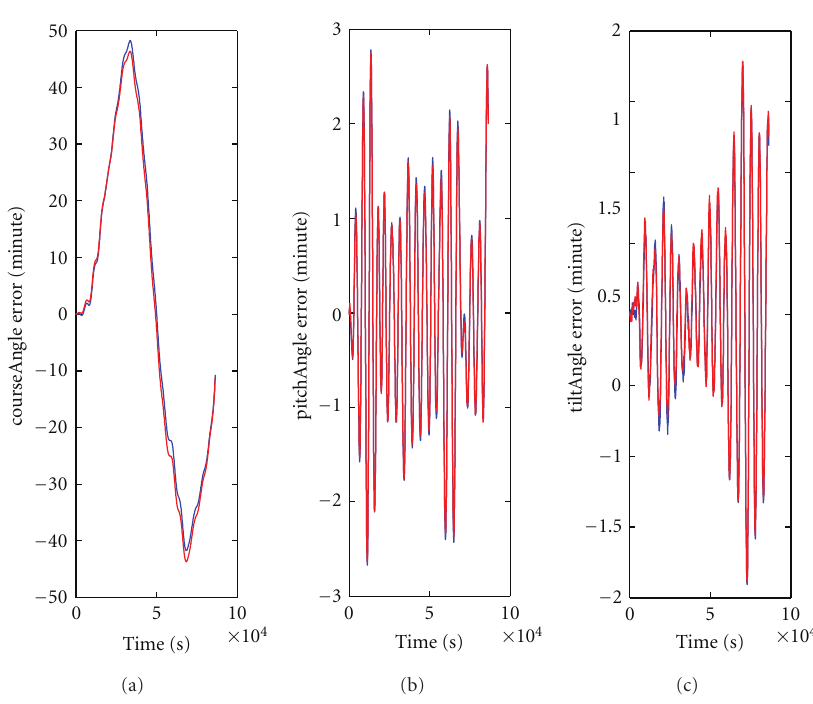
Figure 25: Angle error of real data set